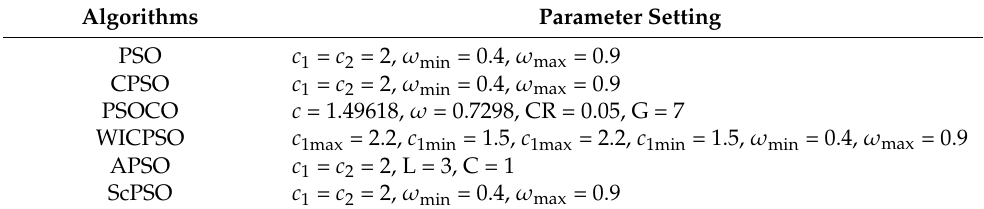
Table 1. Parameters for compared algorithms. Algorithms